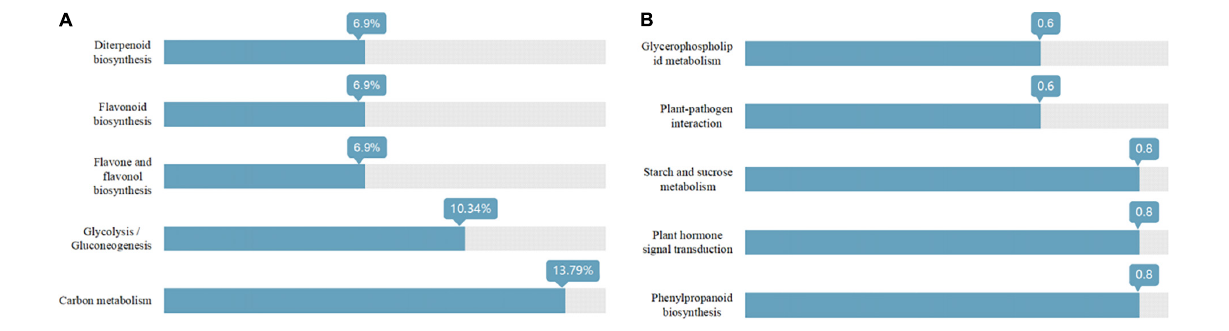
Frontiers in Plant Science |